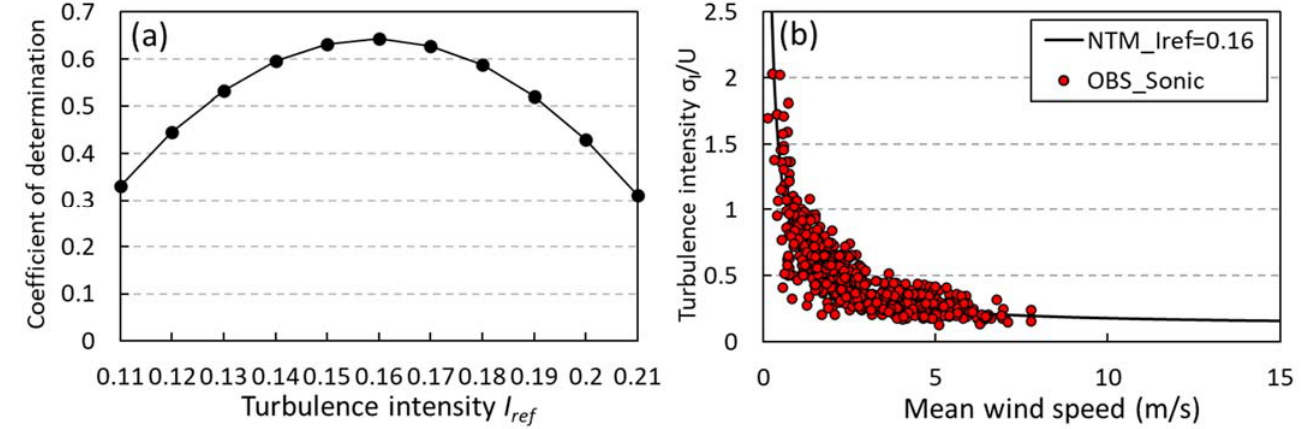
Figure 7. The coefficient of determination for regression analysis ( a ) and variation of the turbulence intensity with the mean wind speed measured by the ultrasonic anemometer placed at the building rooftop ( b ).